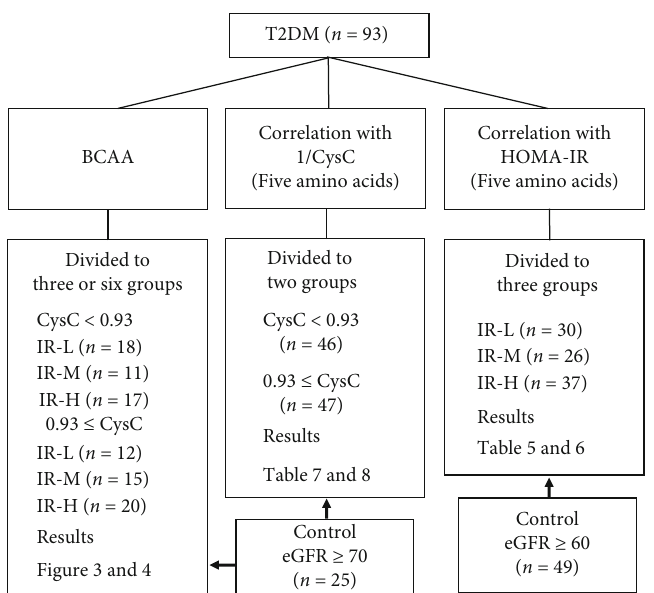
Figure 1: Flowchart of the classi fi cation and number of participants. T2DM: type 2 diabetes mellitus; BCAAs: branched-chain amino acids; CysC: cystatin C; HOMA-IR: homeostasis model assessment of insulin resistance; IR-L, T2DM with HOMA − IR ≤ 1 : 60 ; IR-M, T2DM with 1 : 6 < HOMA − IR < 2 : 5 ; IR-H, T2DM with HOMA − IR ≥ 2 : 5 ; eGFR: estimated glomerular fi ltration rate.